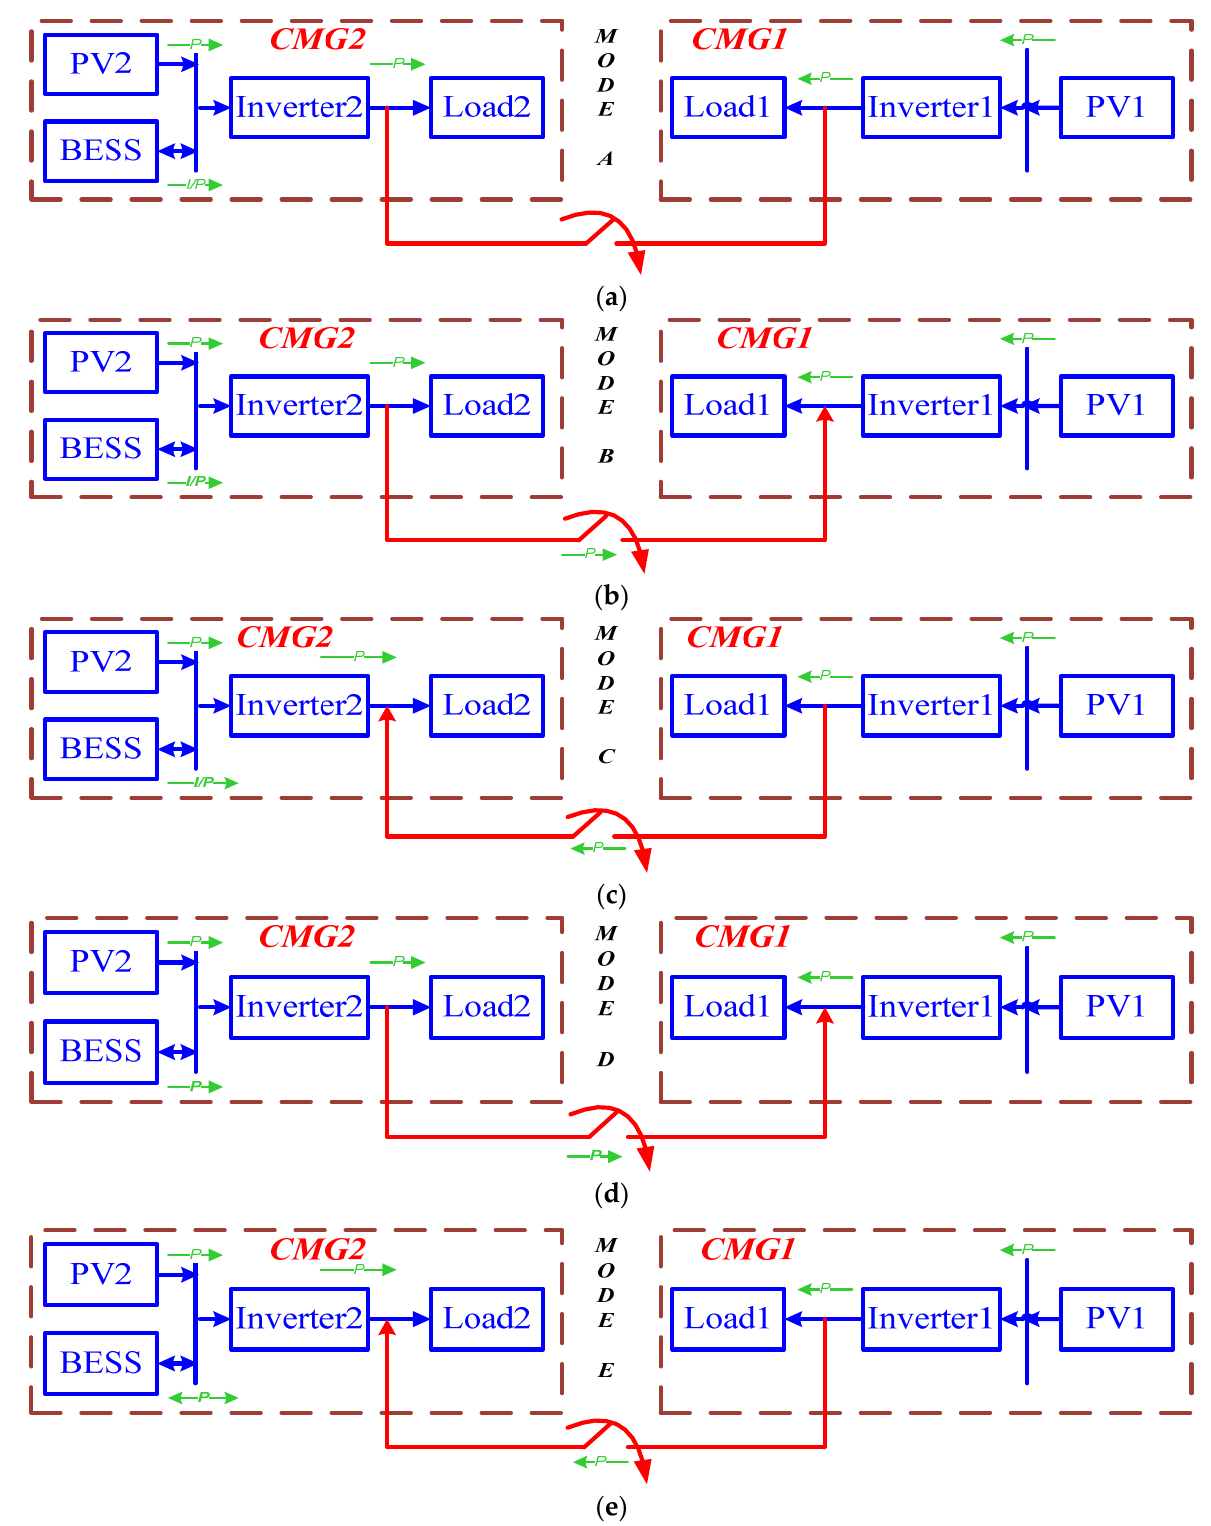
Figure 5. ( a ) Power flow for operation mode A. ( b ) Power flow for operation mode B. ( c ) Power flow for operation mode C. ( d ) Power flow for operation mode D. ( e ) Power flow for operation mode E.